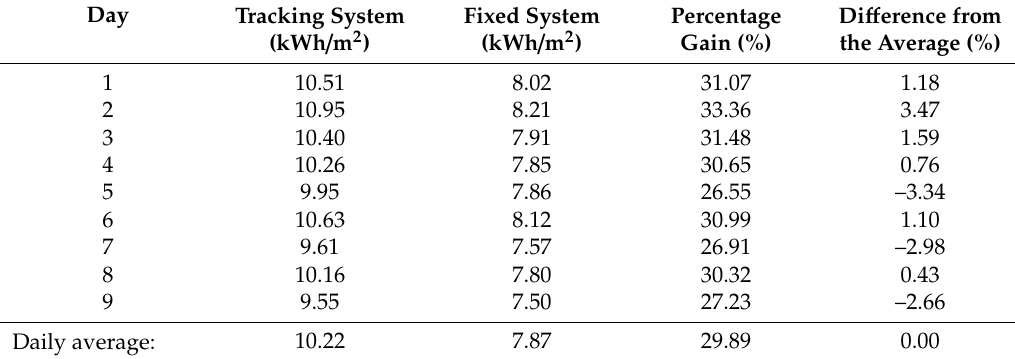
Table 4. Daily irradiation collected by the tracking and the fixed systems for the 9 days of the experimental campaign, percentage gain of irradiation obtained by the tracking system, and di ff erence of the percentage gain from the average